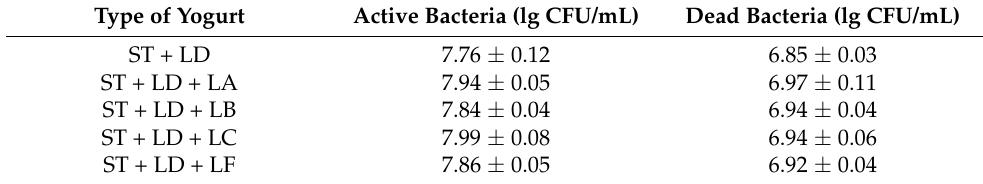
Figure 6. Determination of LAB in Yogurt by Flow Cytometry. ( A , E ) were the FCM distribution of SYTO9 and PI single-stained negative control, respectively. ( B , F ) were the distribution of SYTO9 and PI single-stained negative control cells and fluorescence intensity, respectively. ( C , G ) are the distribution of SYTO9 and PI single-stained positive control flow cells, respectively. ( D , H ) are the distribution of SYTO9 and PI single-stained positive control cells and fluorescence intensity, respectively. Table 7. Enumeration of LAB using FCM.